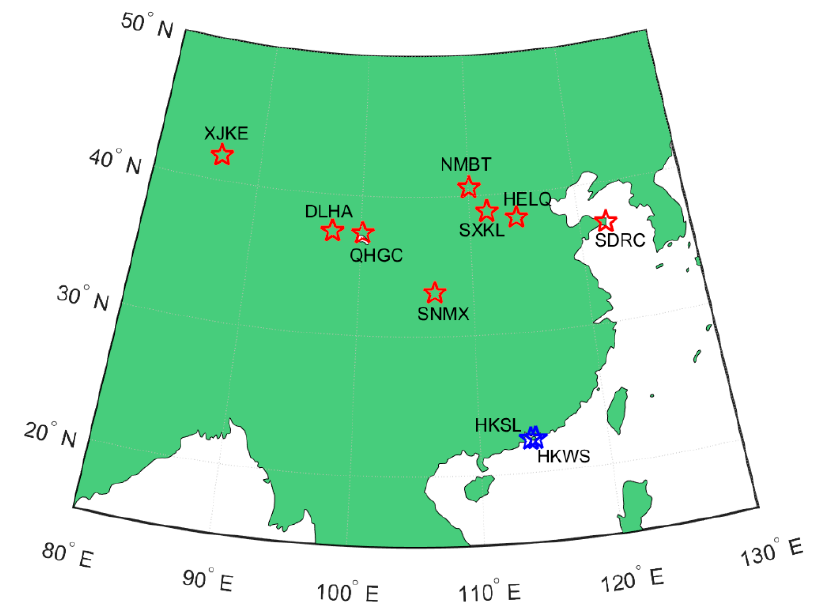
Figure 1. Geographical distribution of the selective MGEX (blue) and CMONOC (red) stations.